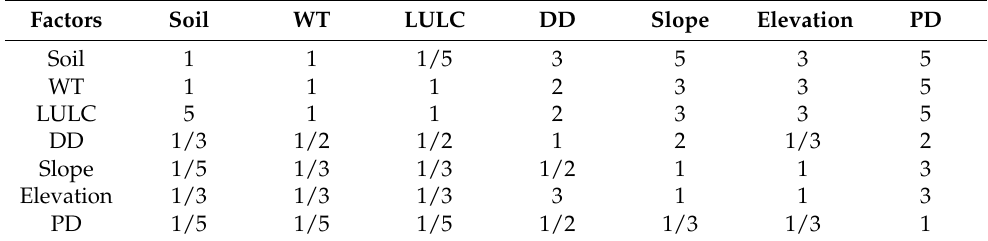
Table 3. Pair-wise comparison matrix.